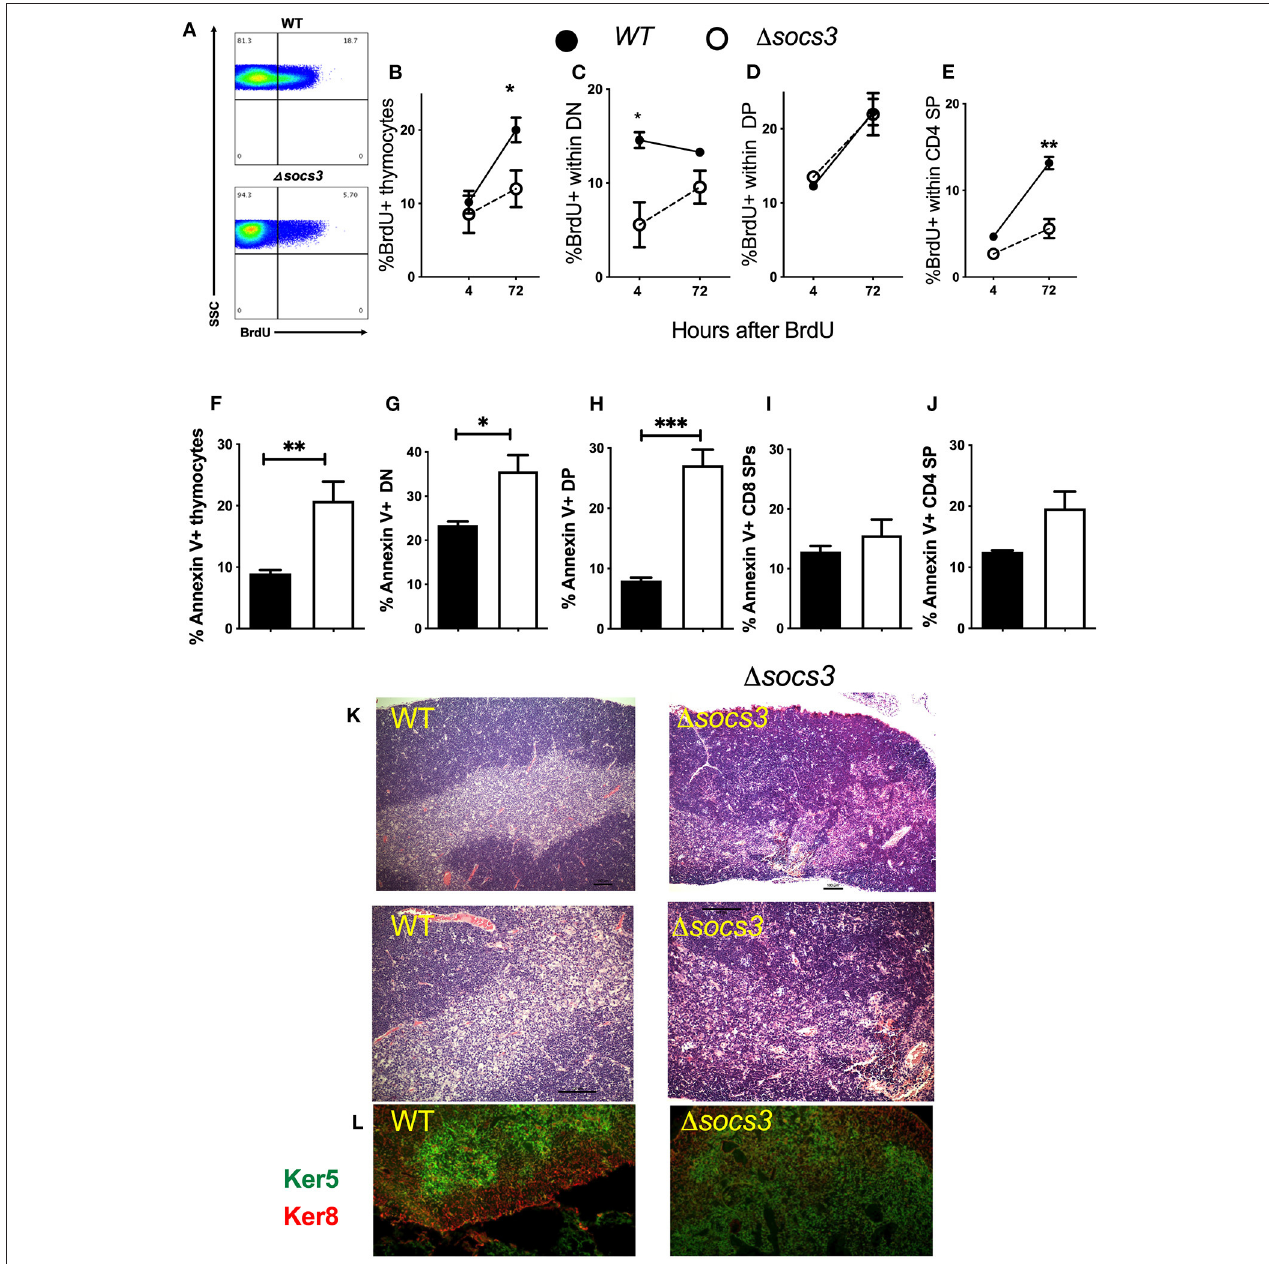
FIGURE 4 | Decreased proliferation, differentiation and increased frequency of apoptosis in 1 socs3 thymocytes. (A) A representative histogram shows BrdU + thymocytes from 1 socs3 and WT mice measured 72h after BrdU administration. (B) The mean frequency of BrdU + thymocytes ± SEM from WT and 1 socs3 mice ( n = 5 animals per groups) 4 and 72h after BrdU inoculation are depicted. The mean frequency ± SEM of BrdU + cells within (C) DN, (D) DP, and (E) CD4 SP 1 socs3 and WT thymocytes at 4 and 72h after BrdU administration is shown. The mean frequencies of Annexin V + (F) total thymocytes and (G) DN, (H) DP, (I) CD4 SP, and (J) CD8 SP subpopulations ± SEM in 1 socs3 and WT mice (at least 5 per group) are shown. Differences between WT and 1 socs3 thymocytes are significant at * p ≤ 0.05, ** p ≤ 0.01, *** p ≤ 0.001, two-way ANOVA and unpaired Student’s t- test. (K) The haematoxylin and eosin staining depicting the organization of thymi from WT as compared to 1 socs3 mice. A representative micrograph from tissues from 5 mice per group analyzed is shown. Scale bar: 100 µ m. (L) Double immunolabelling of keratin 5 and keratin 8 targeting the thymic cortex and medulla, respectively, in WT and 1 socs3 mice is shown.